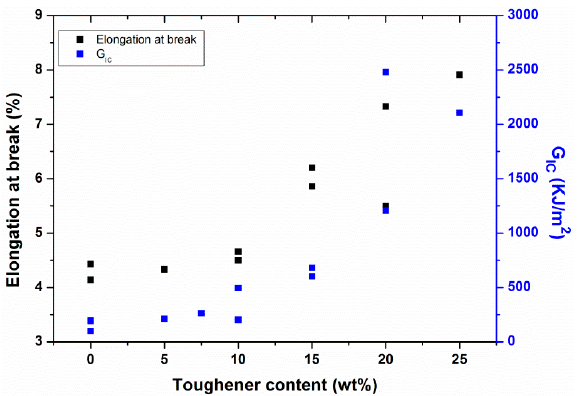
Figure 11. Elongation at break and G IC values as a function of toughener content for BADCy/PEI modified system taken from refs. [32,33,82].